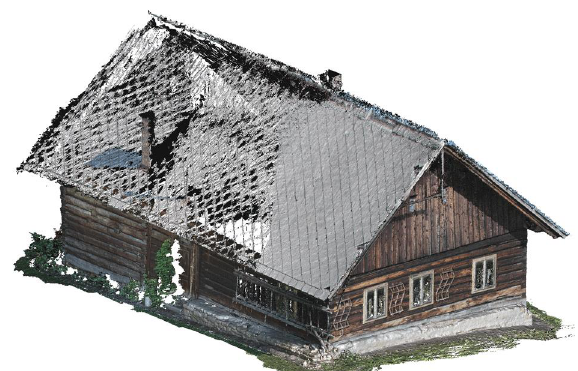
Figure 5. Example of the final point cloud of the examined building, Vigantice (Vsetín dist.)